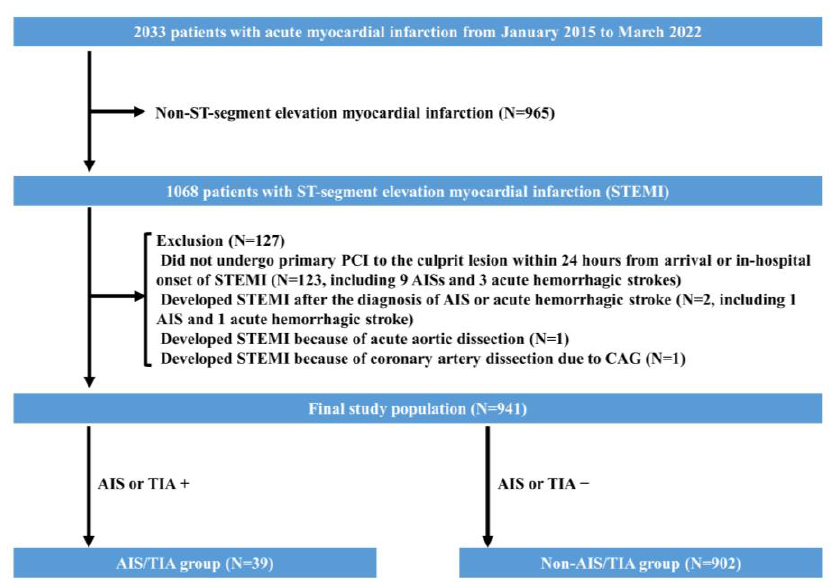
Figure 1. The study flow chart. Abbreviations: AIS = acute ischemic stroke, CAG = coronary angiography, PCI = percutaneous coronary intervention, STEMI = ST-segment elevation myocardial infarction, TIA = transient ischemic attack.